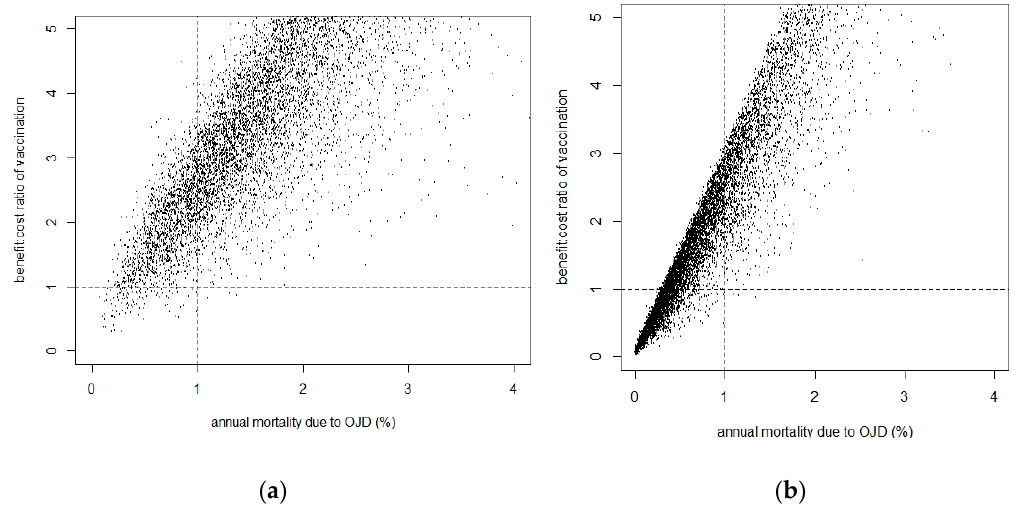
Figure 2. Scatter plots of correlation between annual mortality due to OJD and benefit-cost ratio of vaccination in fine wool ( a ) and other breeds ( b ). The dotted horizontal line represents the breakeven point above which vaccination is beneficial and the dotted vertical line represents the cut point of annual mortality above which most of the flocks have a benefit: cost ratio above one.